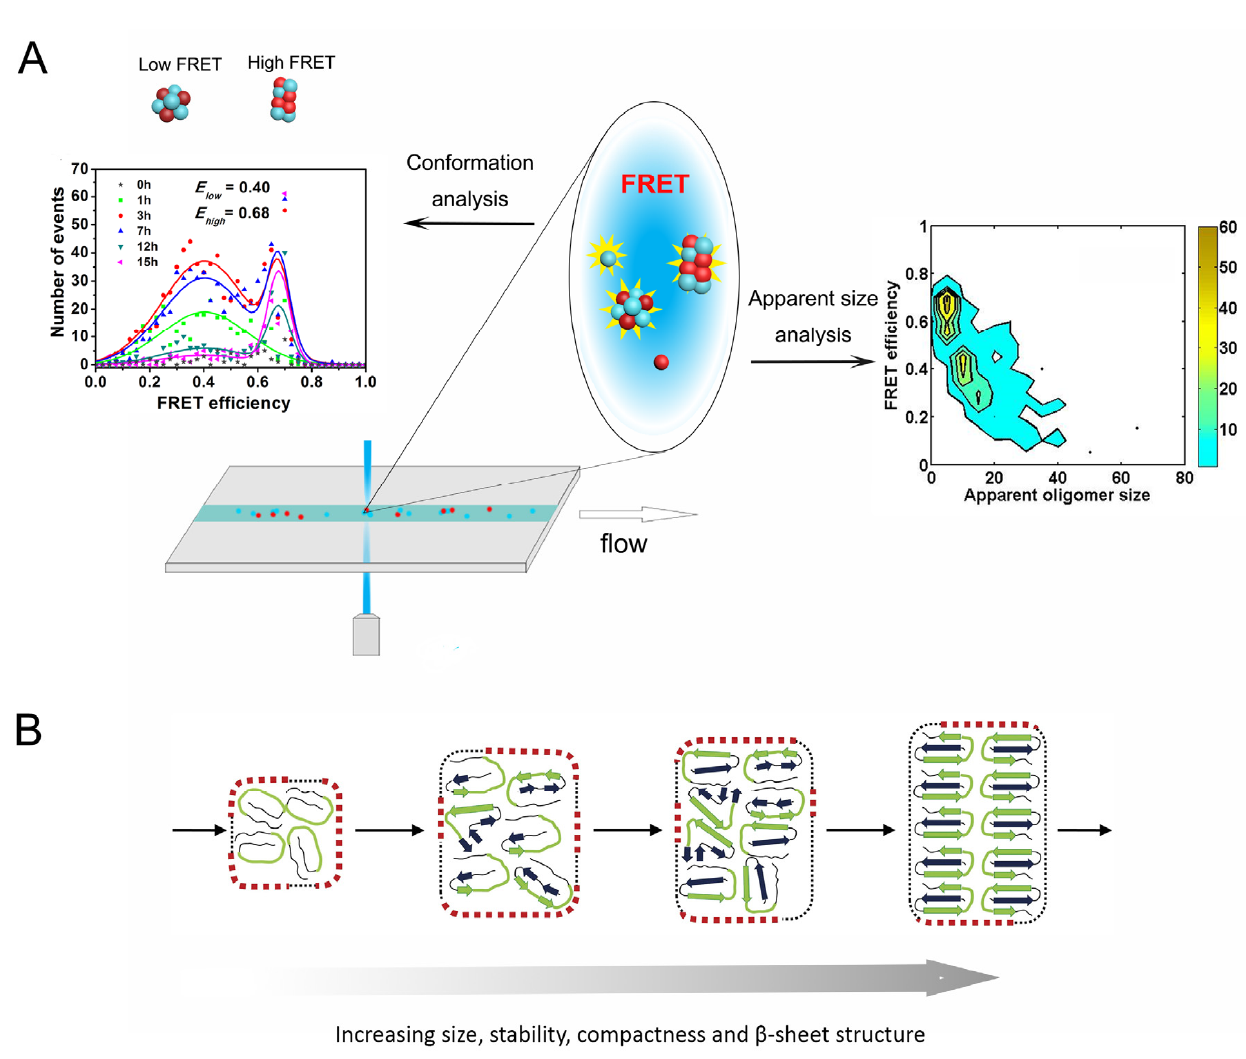
Figure 2. Different conformations of amyloid oligomers detected by confocal single molecule Förster resonance energy transfer (smFRET). ( A ) The FRET distribution of amyloid oligomers at different time points show low- and high-FRET populations which have different apparent sizes. Part of figure reproduced from ref. [57] with permission. (Further permissions related to this part of the figure should be directed to the ACS. Original figures at: https://pubs.acs.org/doi/ 10.1021/jacs.7b10439, accessed on 29 December 2020). ( B ) Schematic representation of the conformational conversion of amyloid oligomers during aggregation reaction. Figure adapted from ref. [15] with